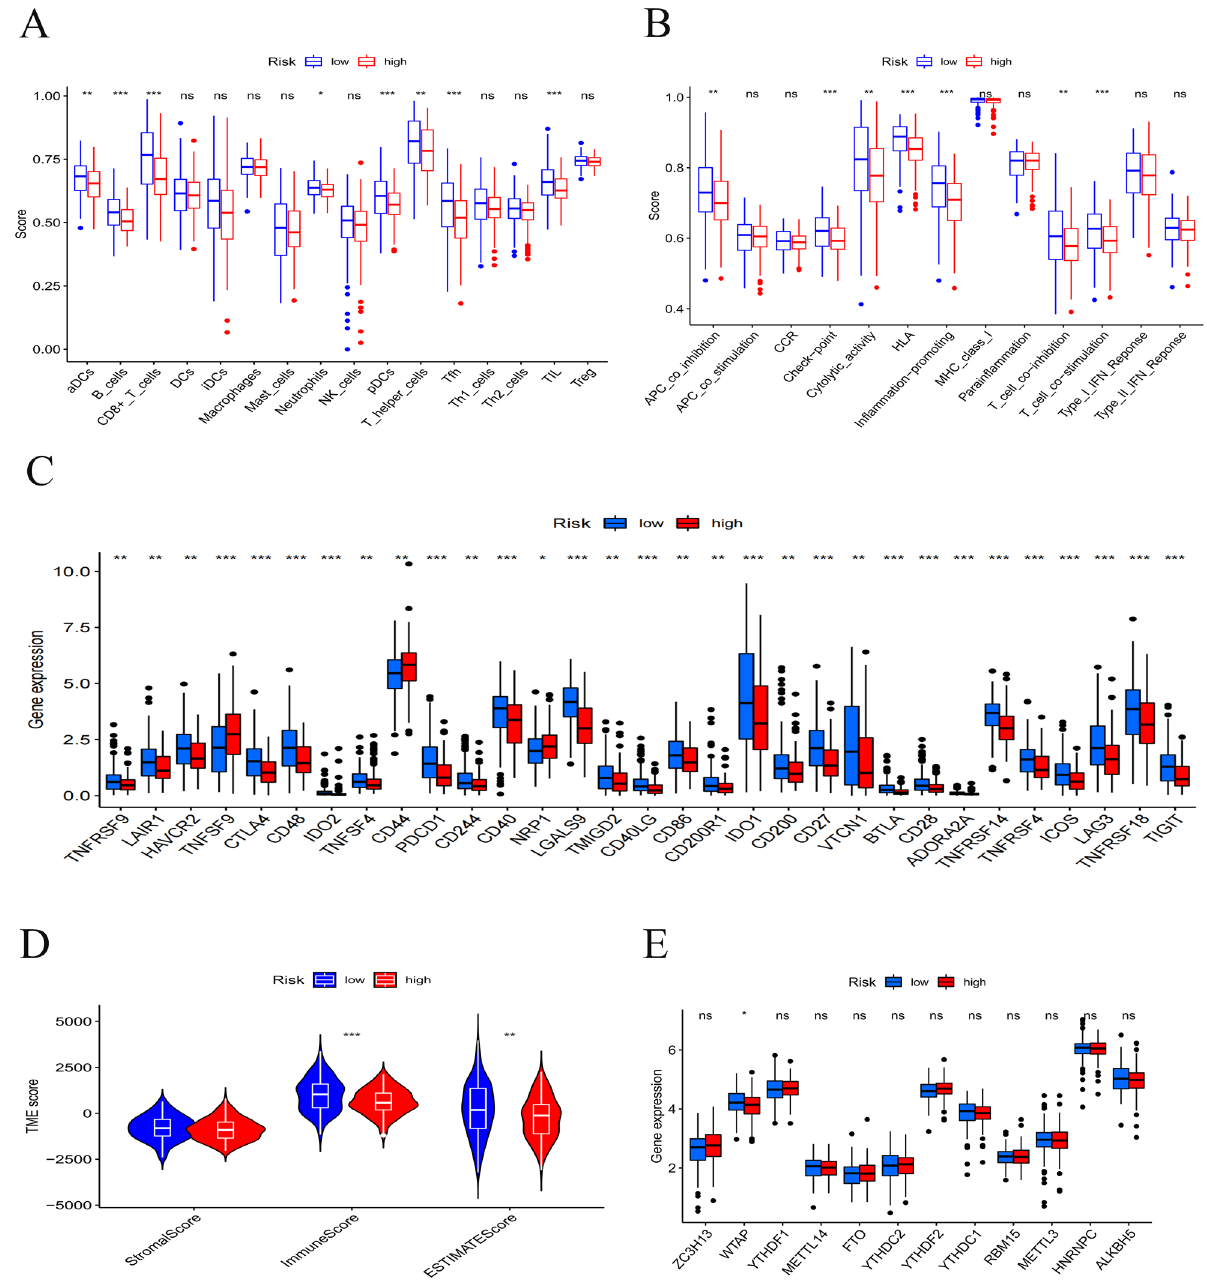
Figure 7. Boxplots of scores of immune cells ( A ) and immune-associated functions ( B ) in risk subgroups. ( C ) Expression of immune checkpoints among two risk subgroups in CESC patients. Associations between risk signature immune microenvironment ( D ) and m6A-related genes ( E